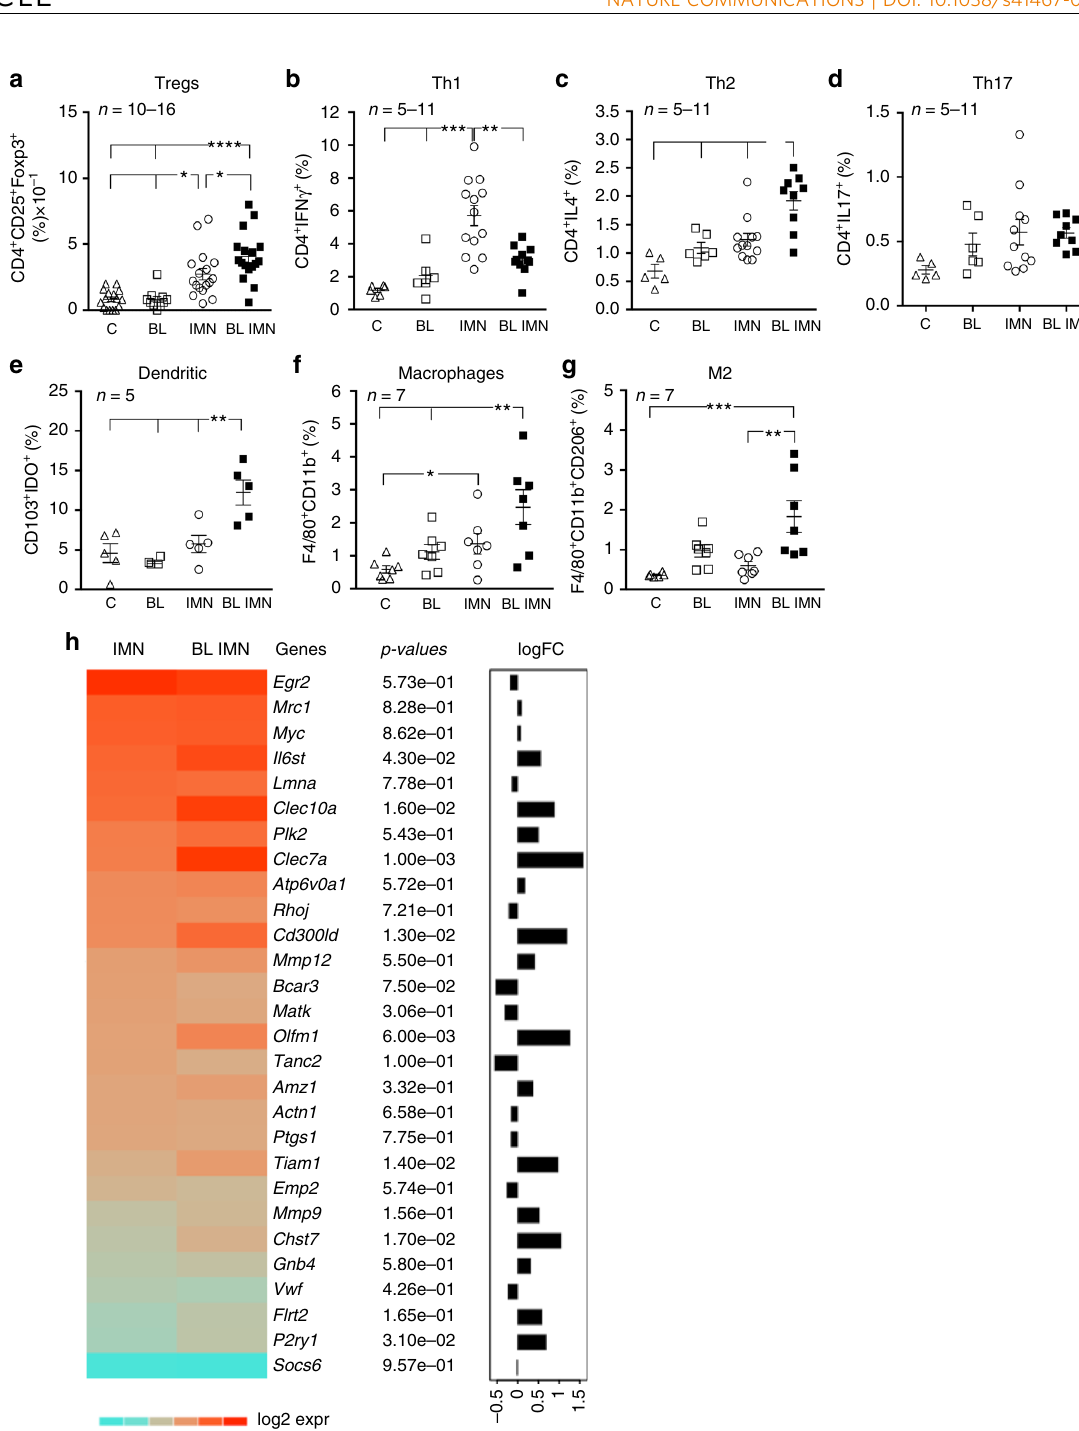
Fig. 3 BL001 promotes a pancreatic anti-in fl ammatory/tolerogenic environment. RIP-B7.1 male and female mice were pre-treated or not with BL001 for 5 days and then immunized. Treatment with BL001 was pursued for an additional 8 weeks at which point animals were sacri fi ced and pancreas extracted and processed for fl ow cytometry quanti fi cation of a Tregs ( n = 10 – 16 mice), b Th1 ( n = 5 – 11 mice), c Th2 ( n = 5 – 11 mice), d Th17 ( n = 5 – 11 mice), e dentritic cells ( n = 5 mice), f macrophages ( n = 7 mice), and g M2-like macrophages ( n = 7 mice). h Heatmap displaying expression values of a subset of M2 macrophage genes in F4/80 + /CD11b + /CD206 + pancreatic subpopulations isolated from immunized mice treated or nor with BL001 (IMN and IMN BL). Also depicted are raw p -values and the graphical representation of logFC from the differential expression analysis (IMN BL versus IMN). * p < 0.05, ** p < 0.01, *** p < 0.001, and **** p < 0.0001, one-way ANOVA ( a – g